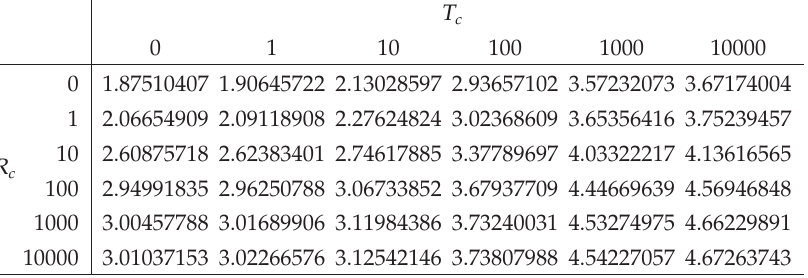
1 for a beam with both ends and